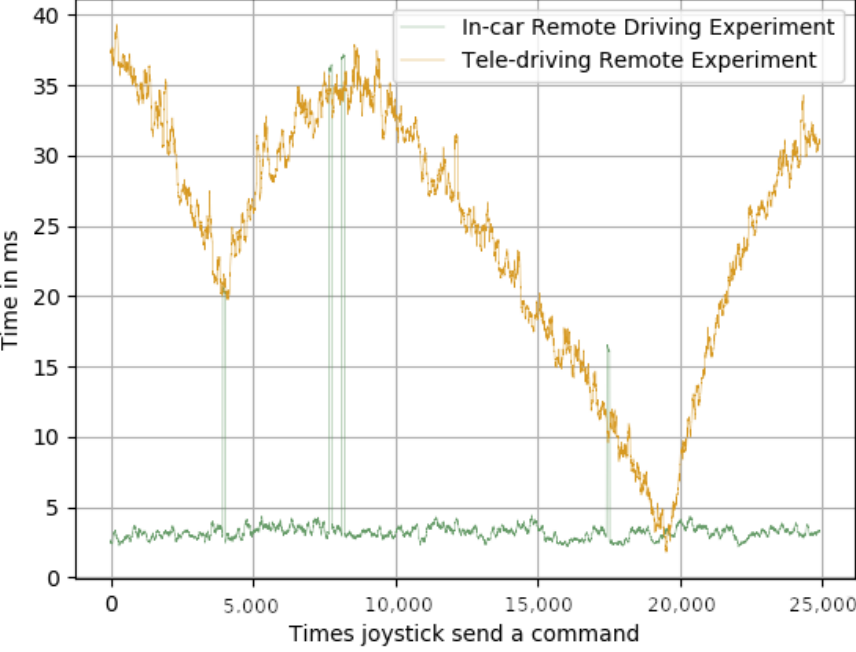
Figure 7. Time in ms of the command in the